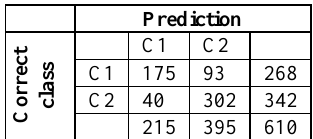
Figure 4. Randomly selected objects present the variation of textural features for intact (top) and destroyed (bottom) buildings.